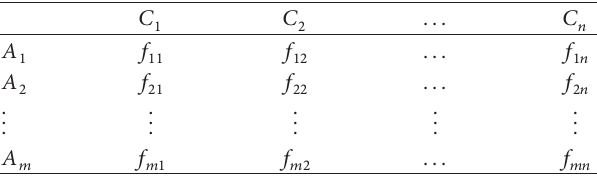
Table 1: Matrix format of a MADM problem. 𝐶 1